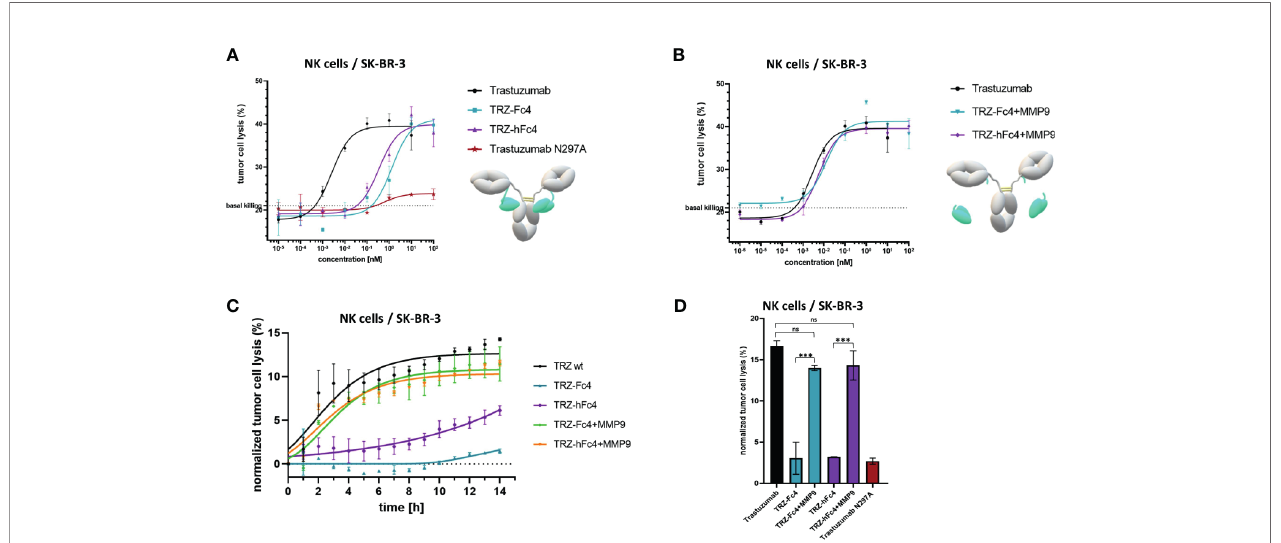
FIGURE 5 | NK cell-mediated tumor cell killing. (A) Cells were incubated with a serial dilution of the Fc-tamed antibody variants TRZ-hFc4 or TRZ-Fc4. Trastuzumab served as a positive control. Trastuzumab N297A served as a negative control. Cells were incubated for 12 hours. (B) Cells were incubated with a serial dilution of MMP-9 cleaved TRZ-hFc4 and TRZ-Fc4 as well as trastuzumab. Cells were incubated for 12 hours. (C) Cells were incubated with 0.01 nM of the respective antibody construct. Tumor cell lysis was determined every 60 minutes. Tumor cell lysis was normalized to the basal killing activity. (D) Cells were incubated with 0.01 nM of the respective antibody construct. After 12 hours tumor cell lysis was calculated. One-way ANOVA and Dunnett ’ s post-hoc multiple comparison testing were performed for statistical analysis. ns (p>0.05); ***(p<0.001). Basal killing, depicted by dashed lines was determined using NK cells mixed with target cells, without the addition of antibody construct. Error bars represent the standard deviation derived from experimental